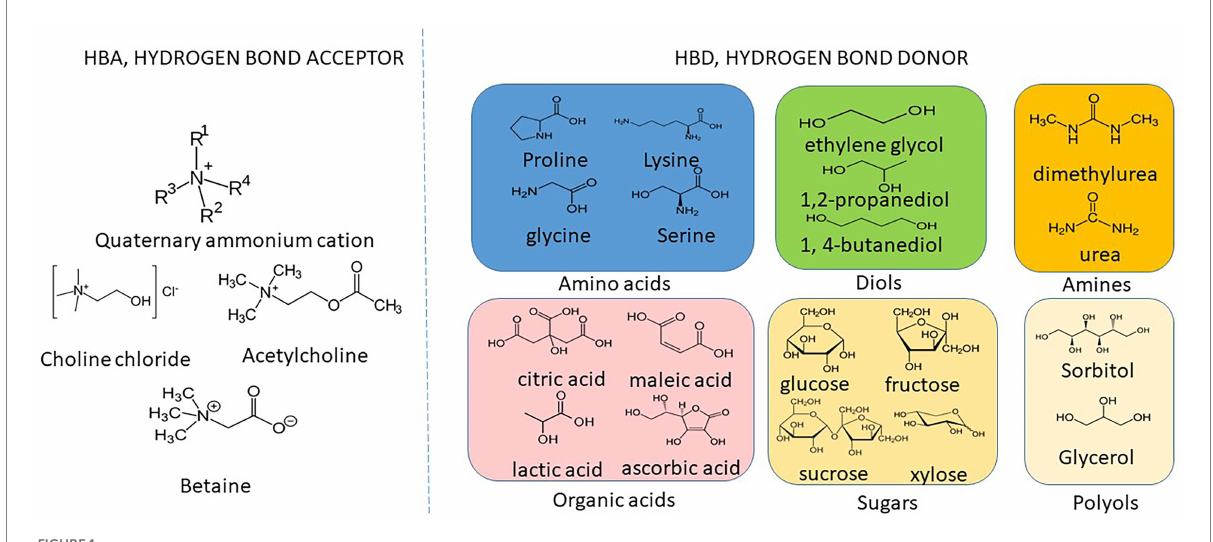
FIGURE 1 Chemical structures of commonly used HBAs and HBDs for the preparation of